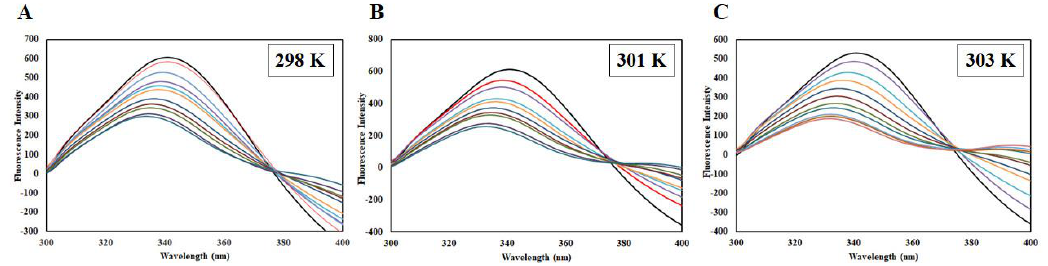
Figure 5. Steady-state fluorescence of CDK6 in the absence and presence of EA (1–10 µ M) at ( A ) 298 K, ( B ) 301 K, and ( C ) 303 K.